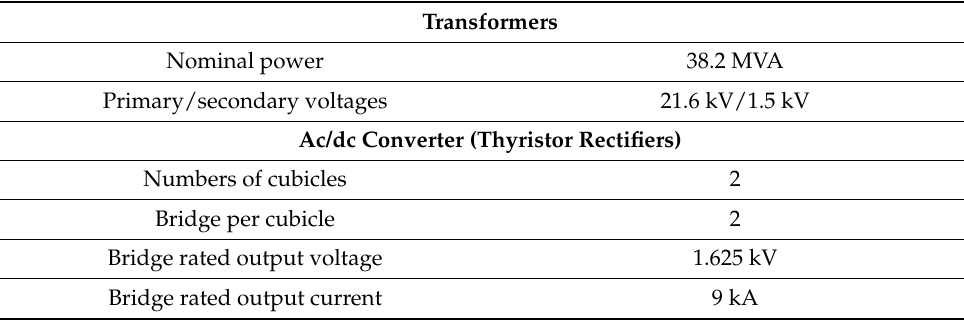
Table 1. Main characteristics of step-down transformers and ac/dc converters.